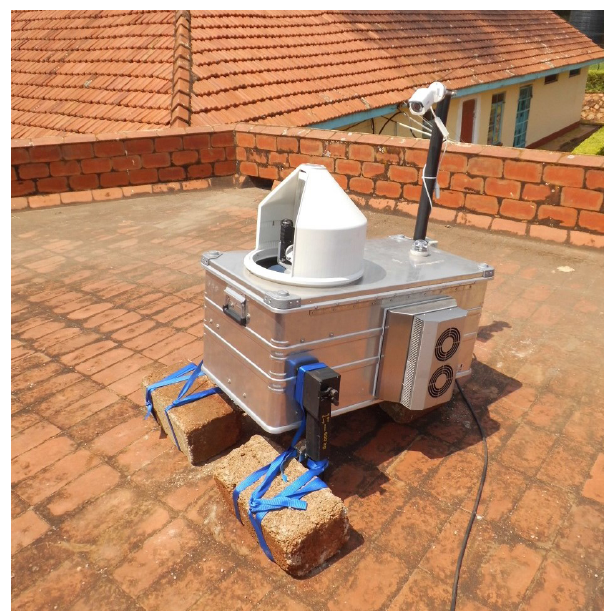
Figure 6. Setup of the tropical version of our enclosure in Jinja, Uganda (Latitude: 0.4 ◦ N). With the help of car jacks the whole sys- tem is tilted in order to enable measurements at high elevation levels close to 90 ◦ . Furthermore, the system is equipped with two 150W thermoelectrical coolers (attached at the two sides of the system) that keep the temperature inside the enclosure constant at 25 ◦ C. Photo by Neil Humpage, University of